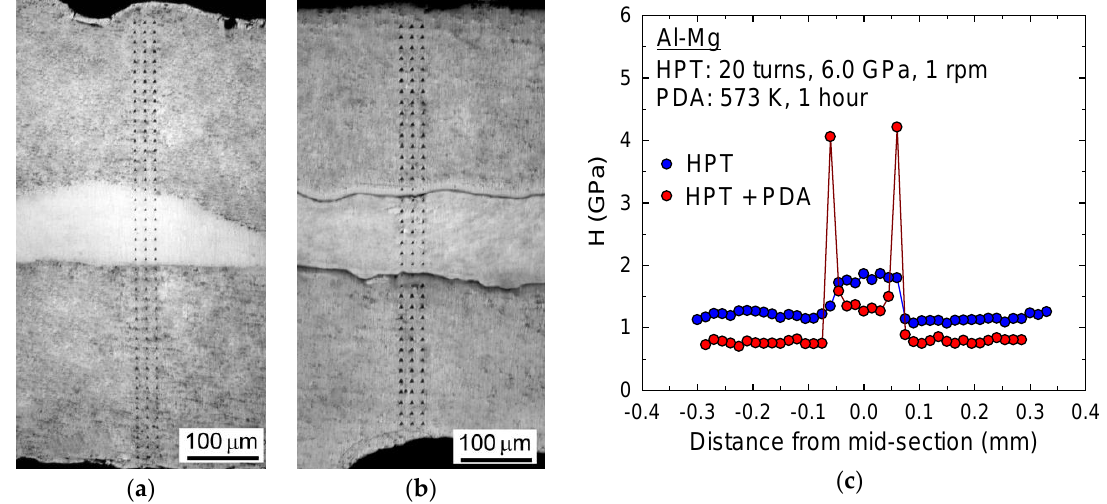
Figure 7. Optical micrographs showing the Al-Mg multi-layers at the disk centers with indentations for the samples after ( a ) HPT for 20 turns and ( b ) HPT and PDA and ( c ) variations of the nanoindentation hardness values for these two sample conditions of the Al-Mg system.